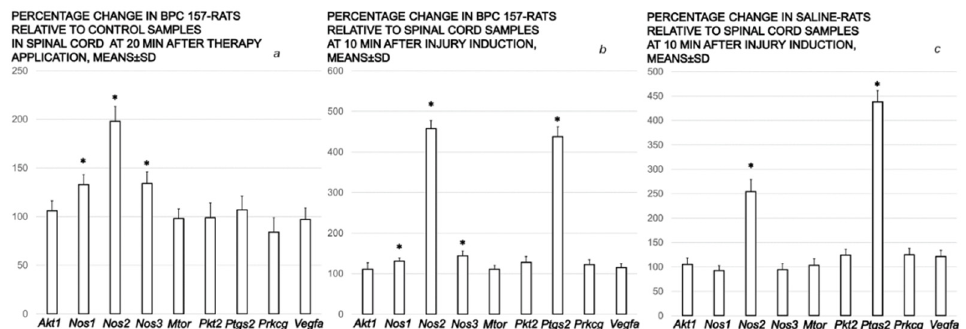
Figure 15. mRNA expression. Real-time PCR determination of mRNA expression of a set of targeted genes in the spinal cord samples. At 10 min after injury saline 5 mL/kg ip or BPC 157 10 µ g/kg ip were applied, and the effects were assessed at 10 min after injury and 20 min after therapy application. Left ( a ). Results are expressed as percentage changes (Means ± SD) of BPC 157 10 μ g/kg relative to the control samples at 20 min after therapy application. Middle ( b ). Results are expressed as percentage changes (Means ± SD) of BPC 157 10 µ g/kg rats at 20 min after therapy application relative to the spinal cord samples at 10 min after injury. Right ( c ). Results are expressed as percentage changes (Means ± SD) of saline 5 mL/kg rats at 20 min after therapy application relative to the spinal cord samples at 10 min after injury. p < 0.05 is marked with *. Results without a * have no biological difference to the control samples.